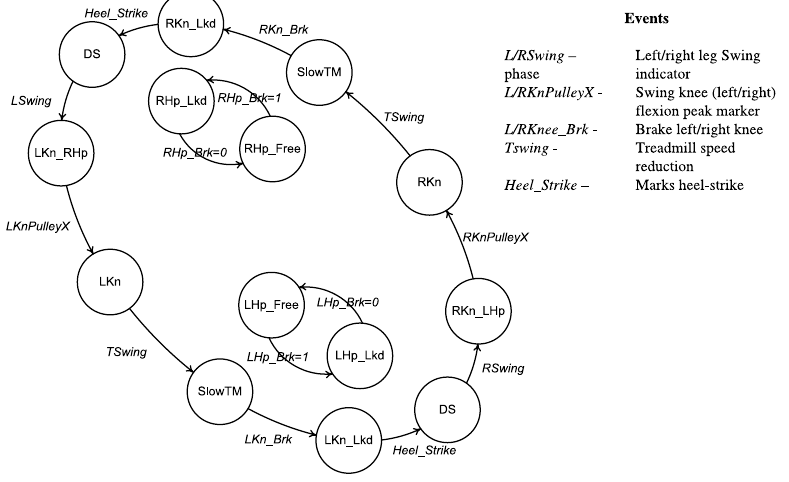
Fig. 4. State graph for the proposed passive treadmill gait cycle